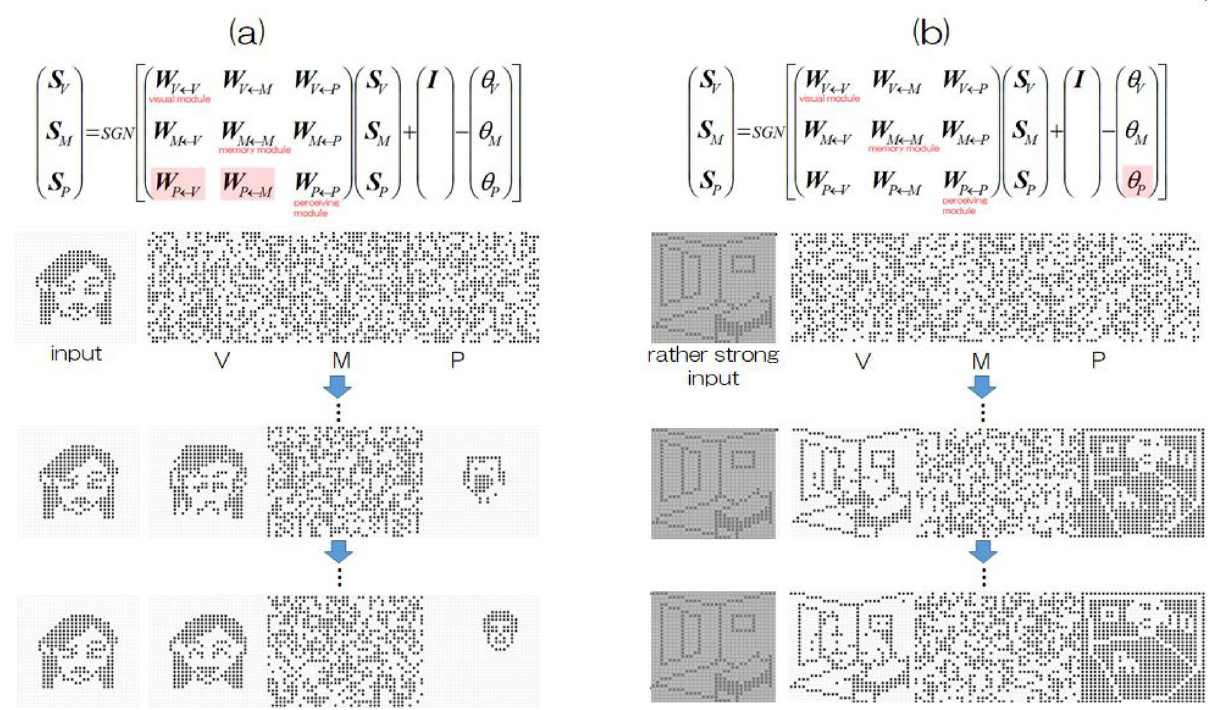
Figure 6. ( a ) An example of deficits in bottom-up information giving rise to erroneous perception initially but finally resulting in veridical perception. ( b ) When thresholds of the perceiving module fluctuate, even rather strong input leads to erroneous perception. Thus, if there are very slow variations in the fluctuations of neuromodulator release due to basal ganglia impairments, it may account for the appearance frequency of hallucinations in patients with RCVH-DLB, for instance, one time per day or a few times per week. In the Supplementary materials of this paper, readers are able to see animations of the time course in neural activity